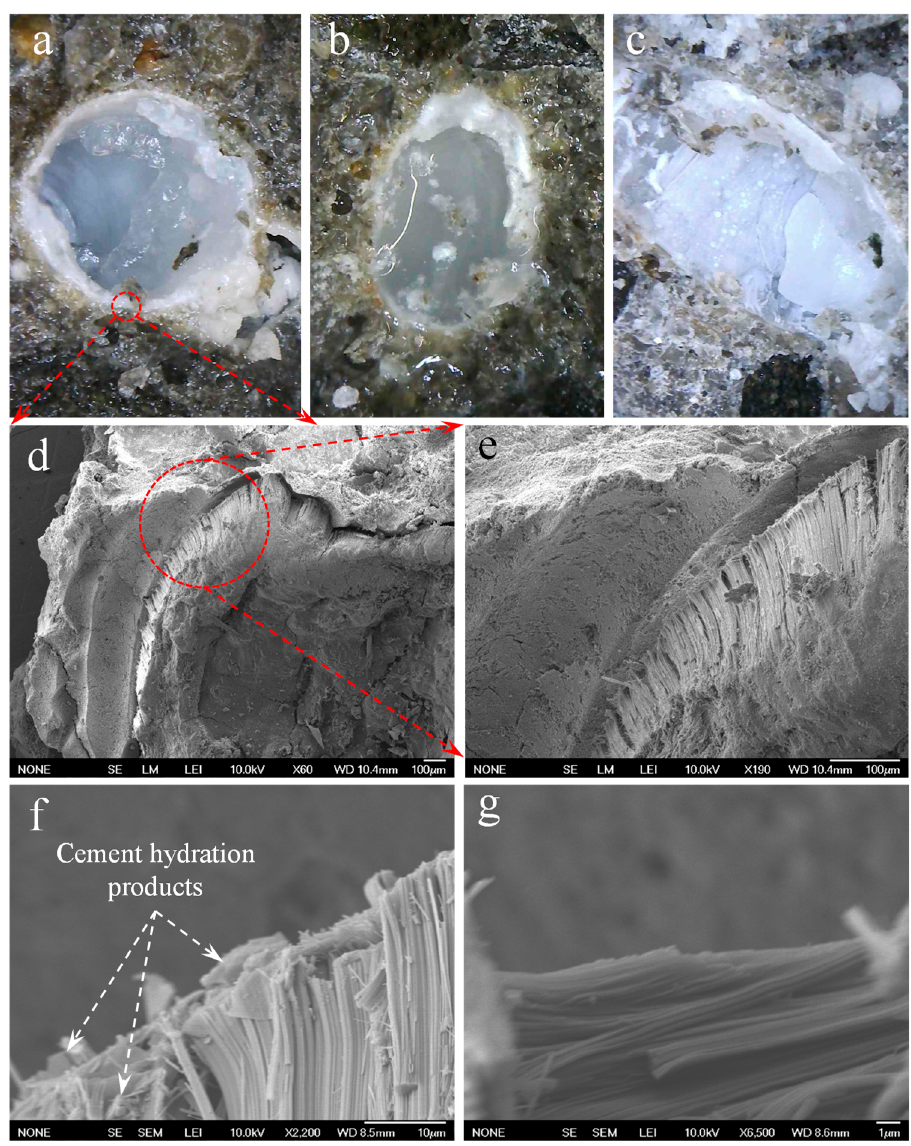
Figure 16. Capsules ruptured along ( a ) minor diameter and ( b ) major diameter containing liquid healing agent, ( c ) reaction products inside and around a ruptured capsule in concrete for 90 days under a digital microscope, ( d ) and ( e ) interface between a capsule and the cement matrix under SEM, ( f ) and ( g ) micro-texture of the ruptured biomass capsule in mortar after 270 days.